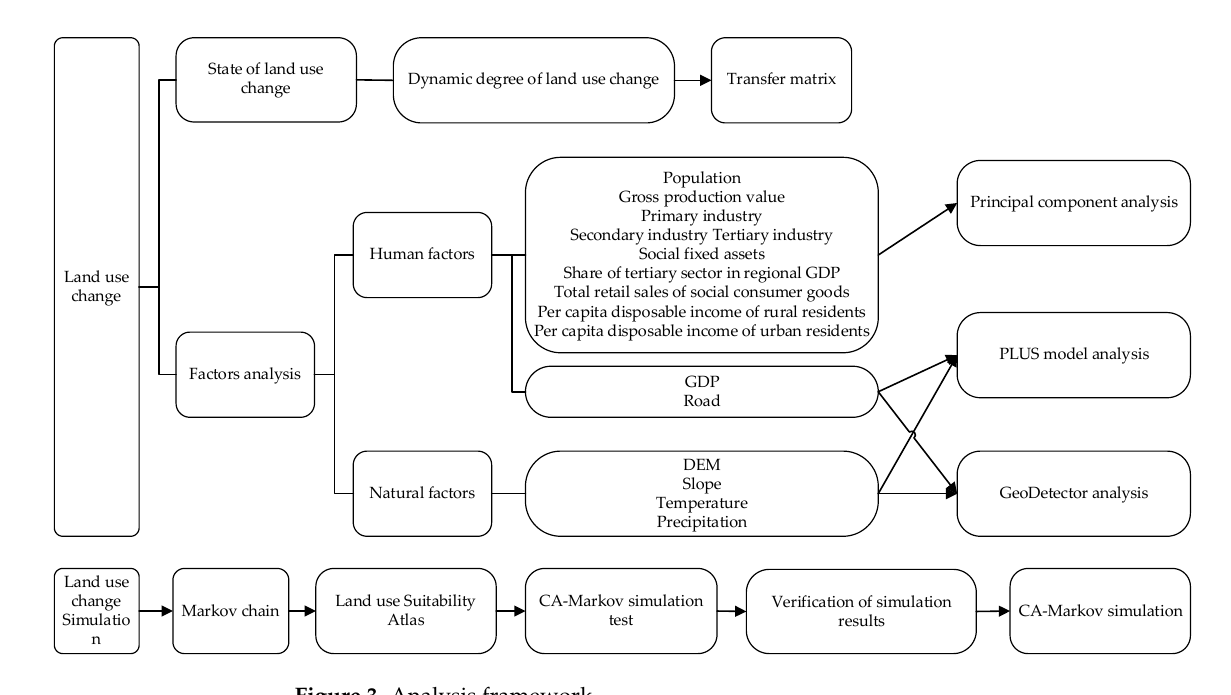
Figure 3. Analysis framework.